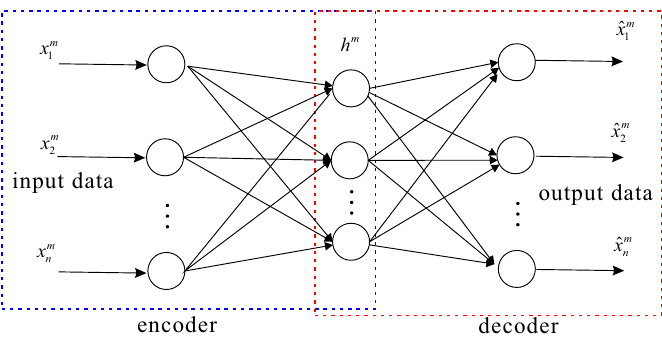
Figure 1. Architecture of an auto-encoder and decoder in a deep neural network